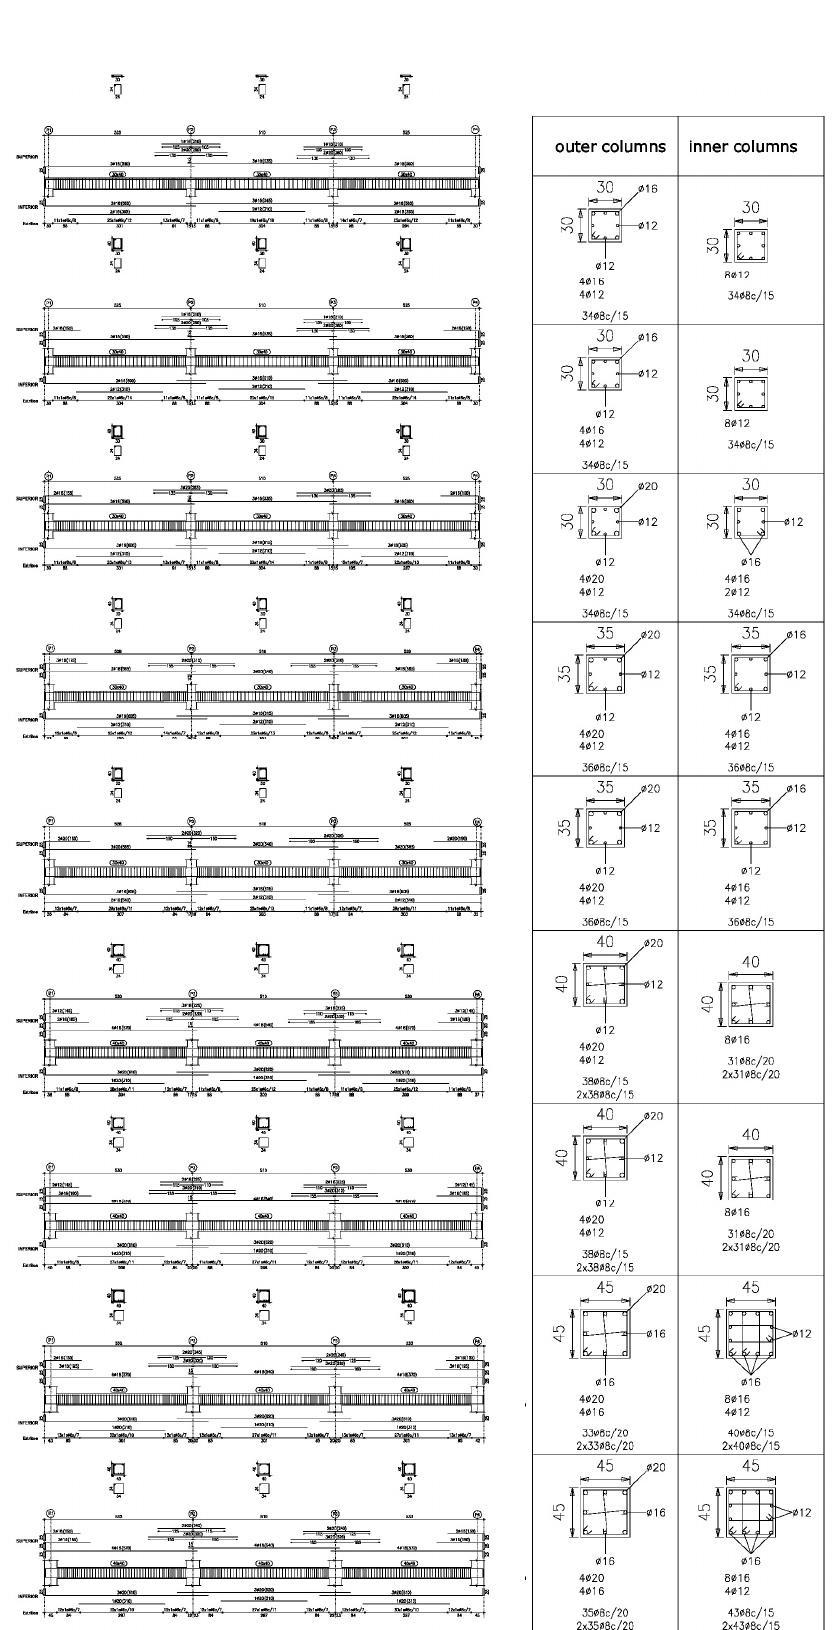
Figure A3. Dimensions and reinforcement for the 9-storey